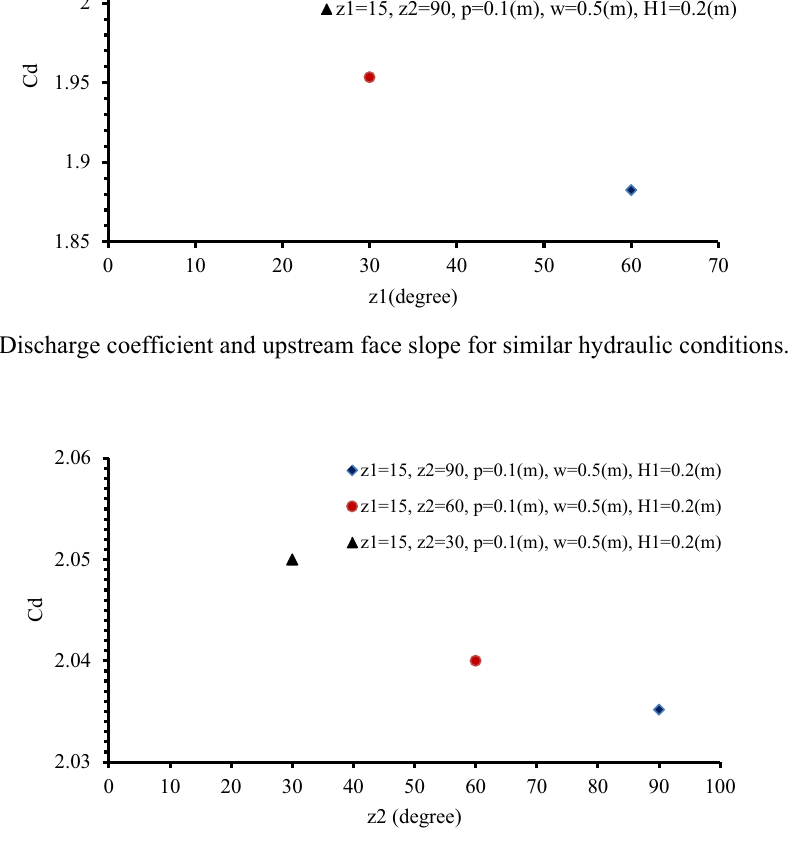
Fig. 13 Discharge coefficient as a function of z 1 and z 2